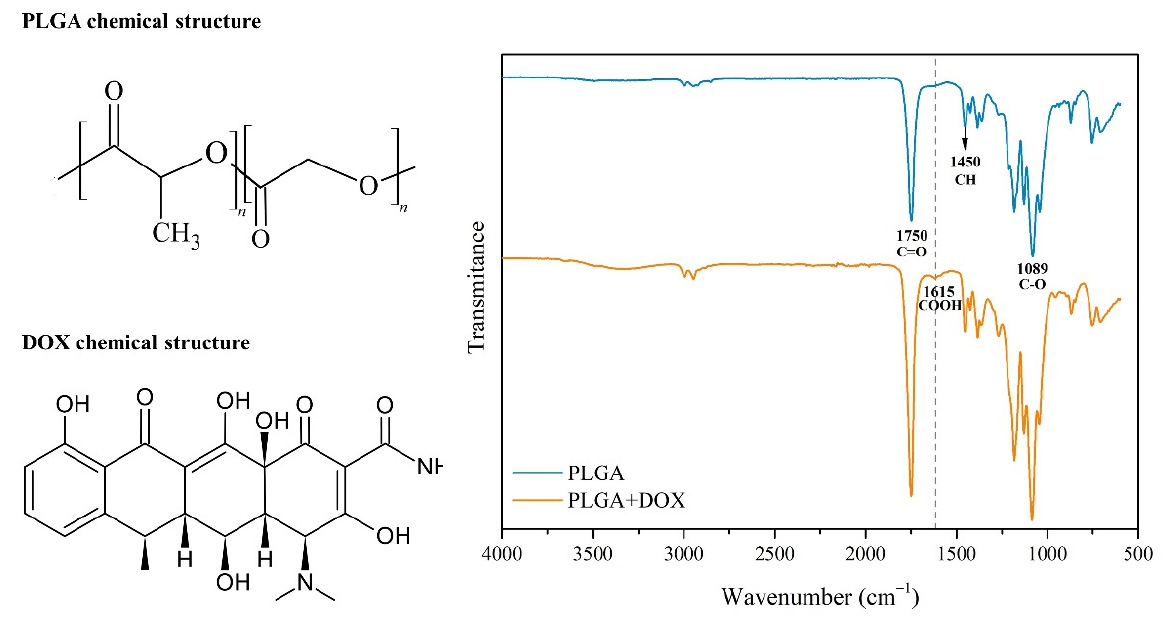
Figure 2. FT − IR spectra of PLGA and PLGA + DOX microspheres.